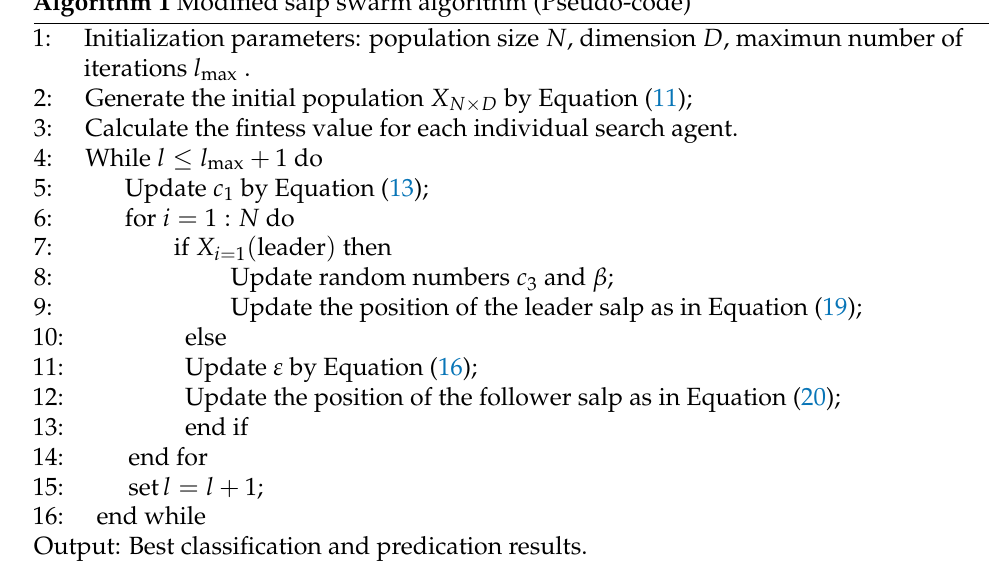
Algorithm 1 Modified salp swarm algorithm